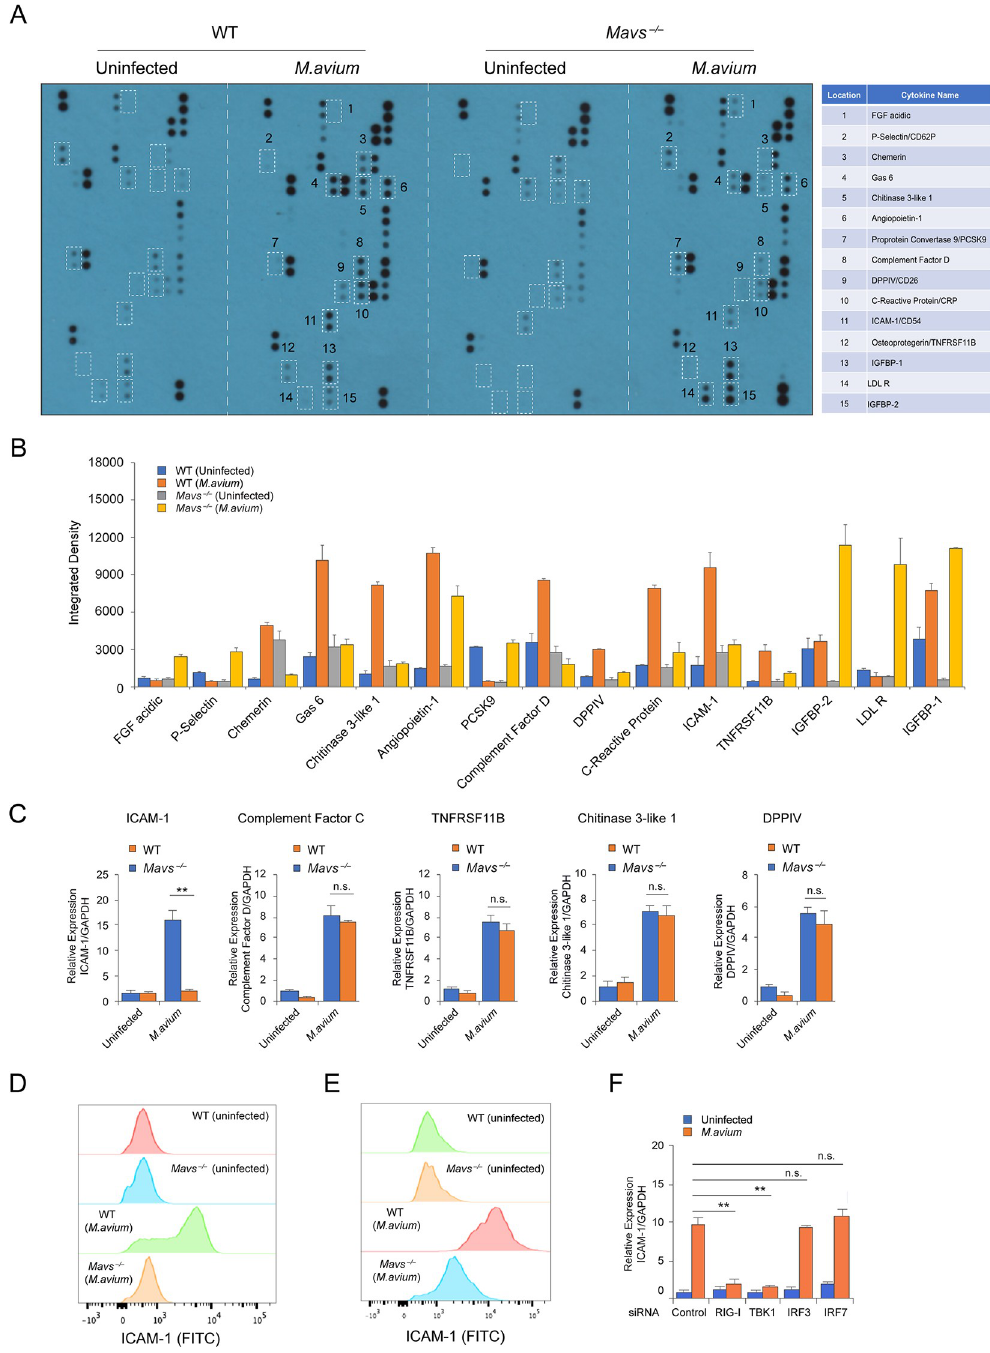
Fig 3. M . avium induces ICAM-1 production in macrophages through a RIG-I/MAVS/TBK1-dependent pathway. (A) Cytokine array analyzing indicated serum proteins in WT and Mavs -/- mice 3 weeks post M . avium intratracheal infection using a dose of 1x10 7 CFU/mouse. (B) Densitometry of serum proteins highlighted in (A). (C) qRT-PCR analysis of designated transcripts in uninfected or M . avium 104 infected WT and Mavs -/- BMMs 24 hr post infection. Uninfected WT set to 1.0. (D) Flow cytometry analysis for ICAM-1 expression by uninfected or M . avium 104 infected WT and Mavs -/- BMMs 24 hr post infection. (E) Flow cytometry analysis for ICAM-1 surface expression on AMs isolated from uninfected or M . avium -infected WT and Mavs -/- mice 3 weeks post infection. (F) qRT-PCR for ICAM-1 in M . avium -infected WT BMMs (24 hr post infection) that were pretreated with control, RIG-I, TBK1, IRF3 or IRF7 siRNA. Control uninfected set to 1.0 Data shown in (C and F) are the mean ± SD (n = 3 wells per group), and all data are representative of two (A and B) or three